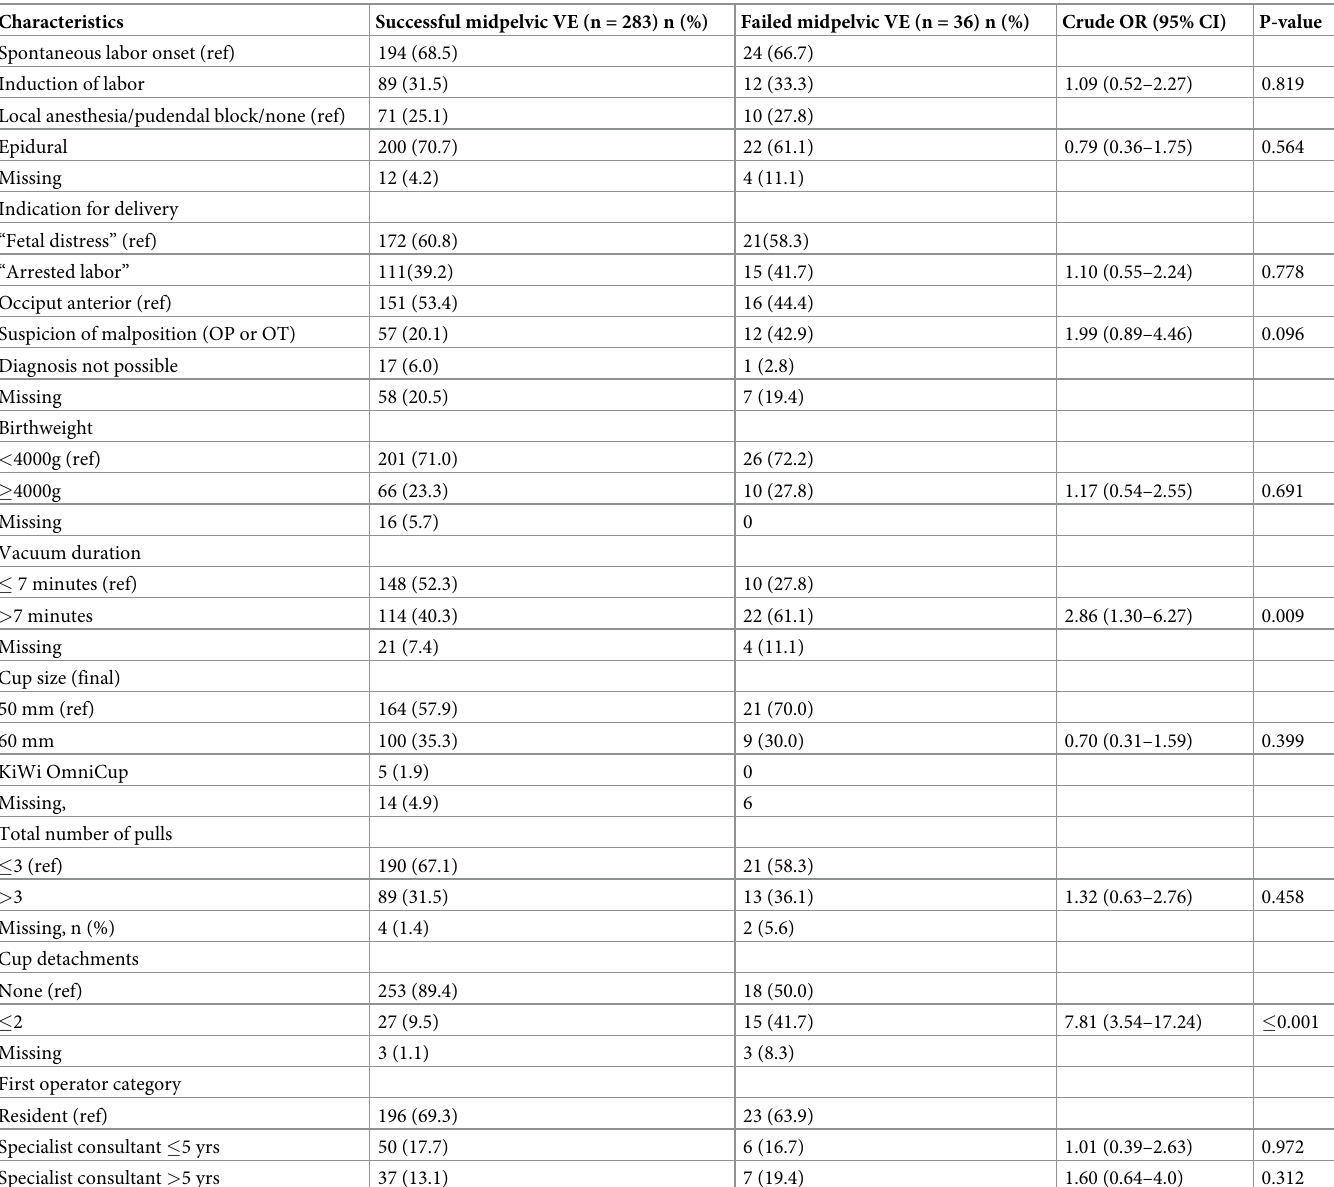
Table 2. Labor characteristics and operator category in attempted midpelvic vacuum extractions (n = 319) with odds ratio indicating the risk of failure.